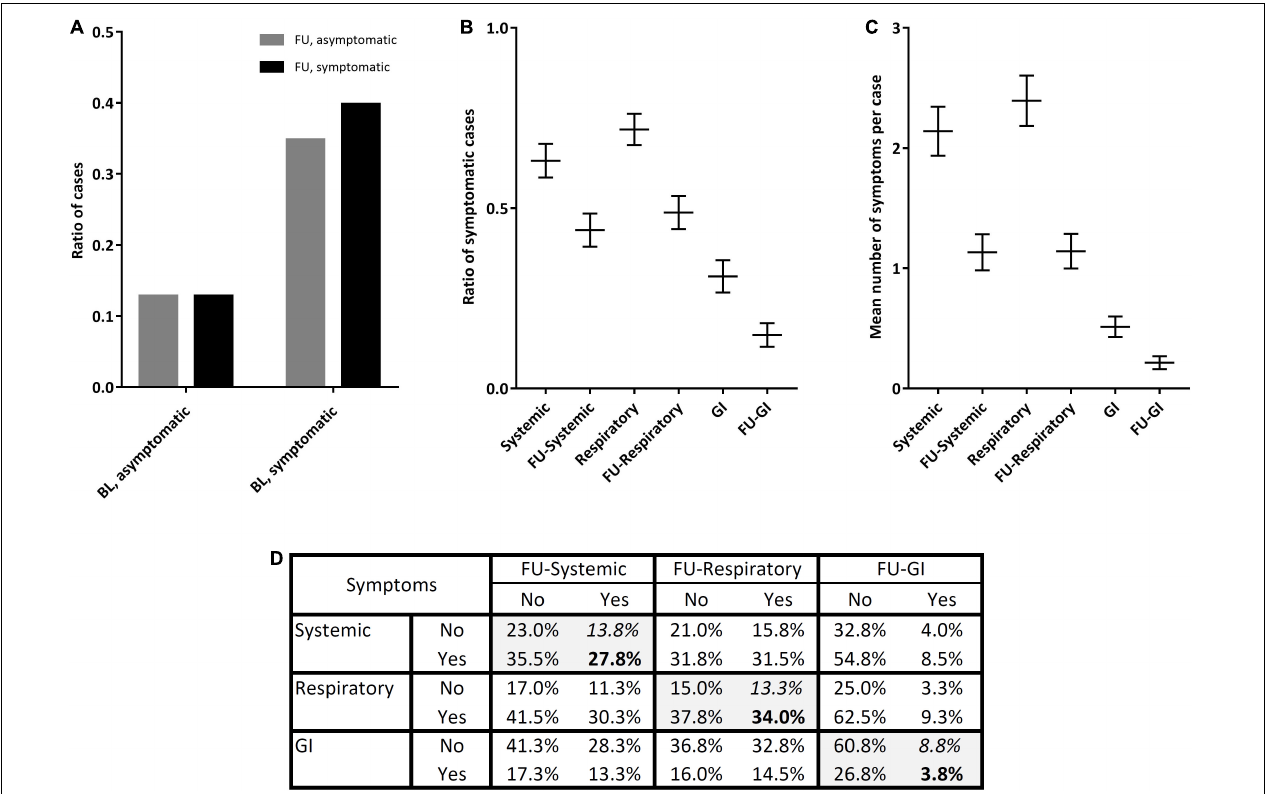
FIGURE 2 | Alterations in the global symptoms as well as the systemic, respiratory, and gastrointestinal (GI) symptoms of 472 COVID-19 patients at the baseline and after 3-month FU. (A) The ratio of symptomatic and asymptomatic cases. (B) The ratio of symptomatic cases in each symptom class. (C) The mean number of symptoms per case in each symptom class. (D) The cross-tabulation of symptomatic and asymptomatic subjects at the baseline and FU. (BL: baseline, FU: follow-up, and GI: gastrointestinal).